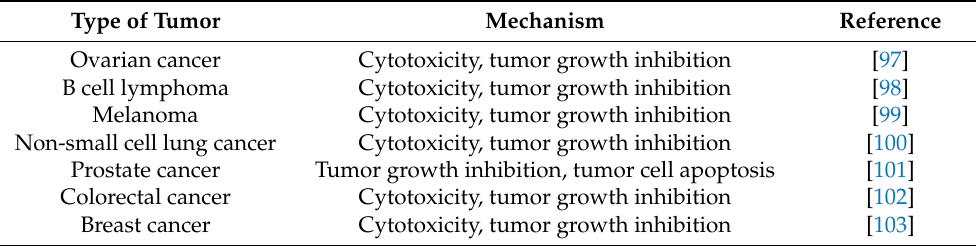
Table 1. Tumors in which mast cells exert anti-tumorigenic